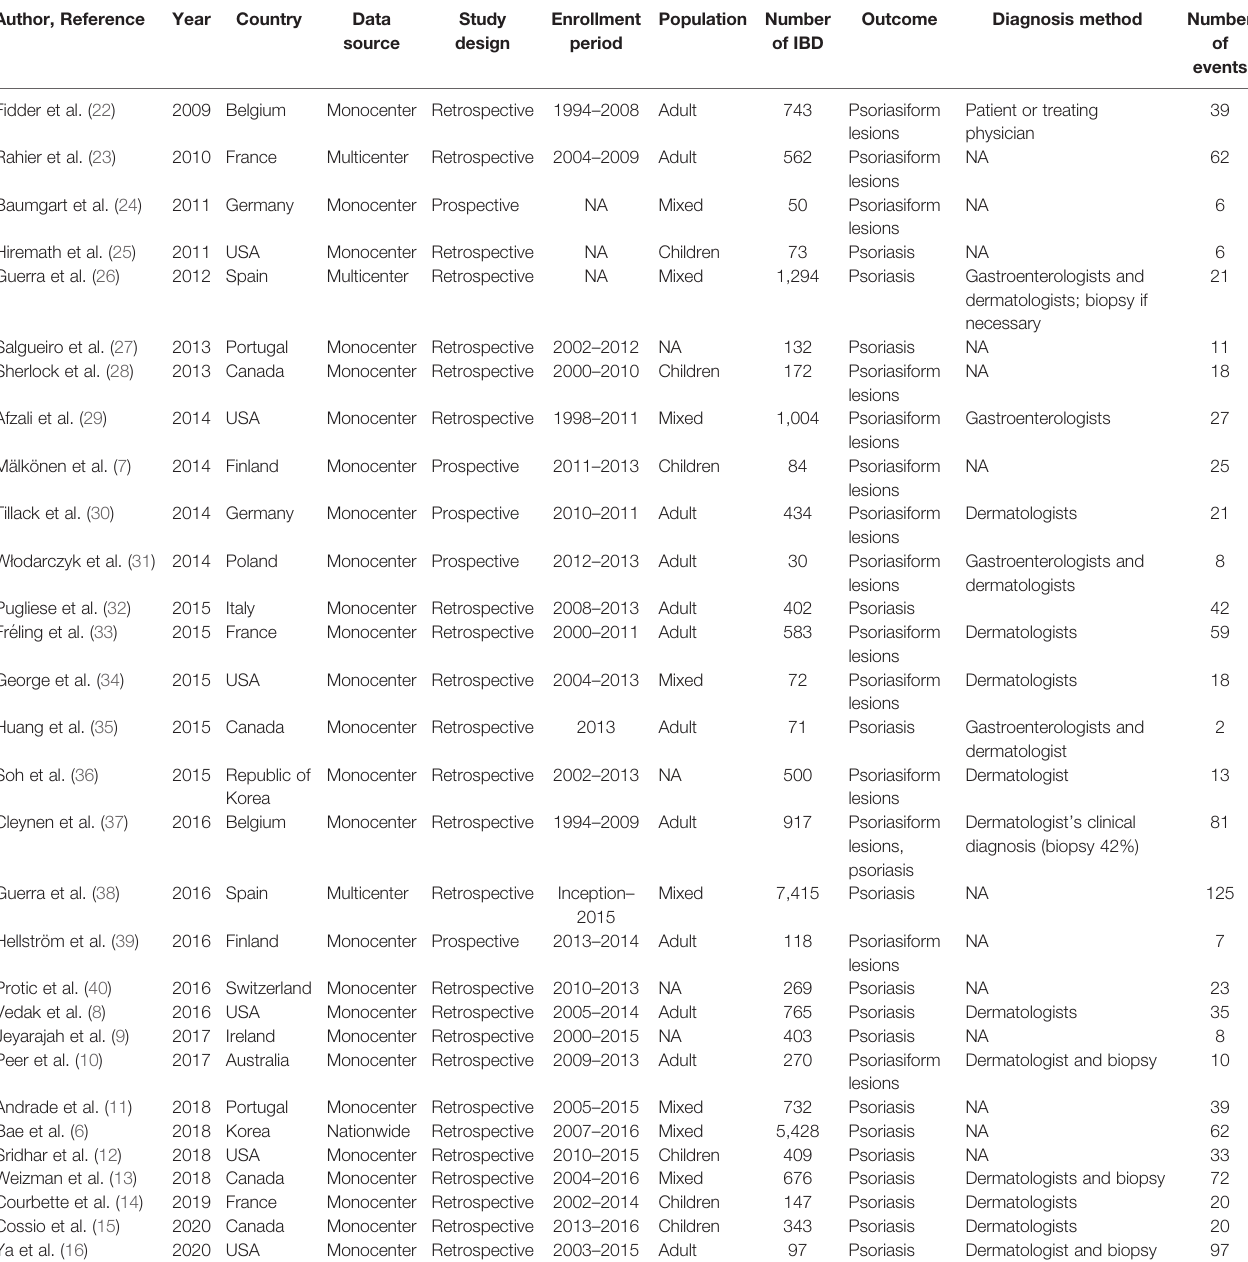
TABLE 1 | Characteristics of the studies included in the